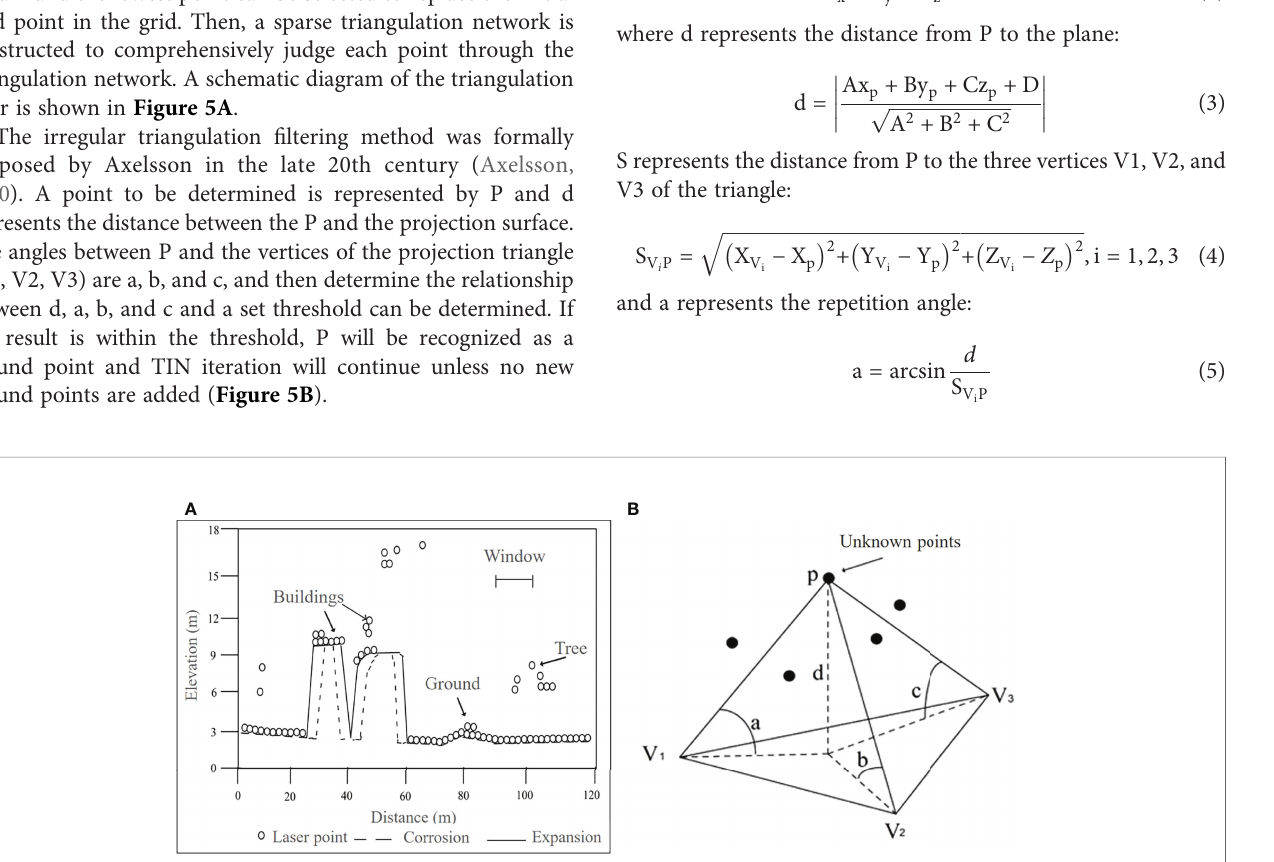
FIGURE 5 | (A) Schematic diagram of mathematical morphological fi ltering; (B) principle diagram of triangulation fi